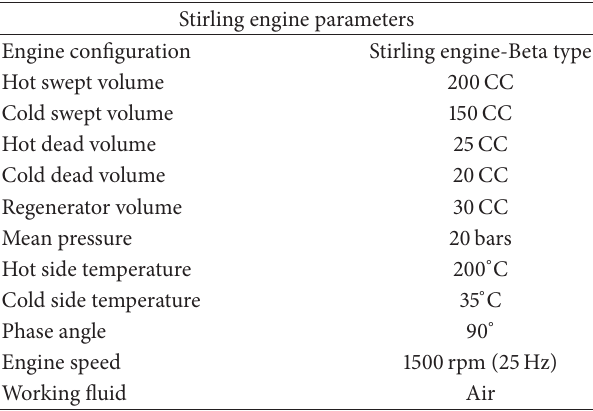
Table 3: Parameters and specifications of Stirling